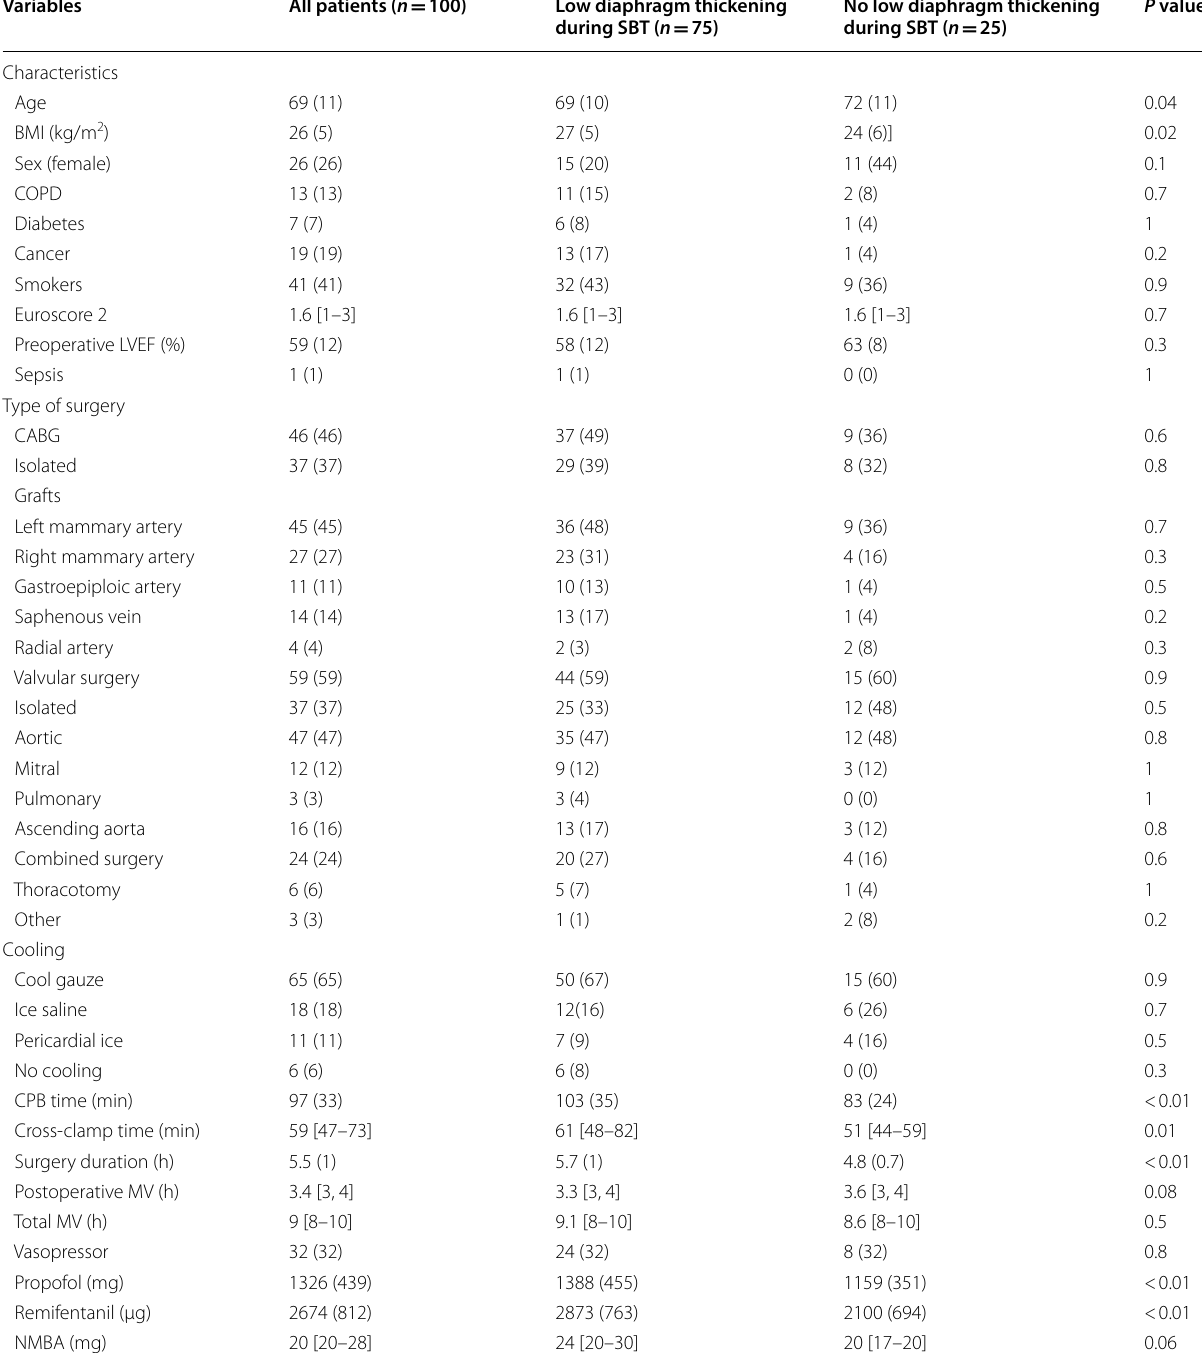
Table 1 Population characteristics before and during surgery, according to diaphragm thickening during spontaneous breathing